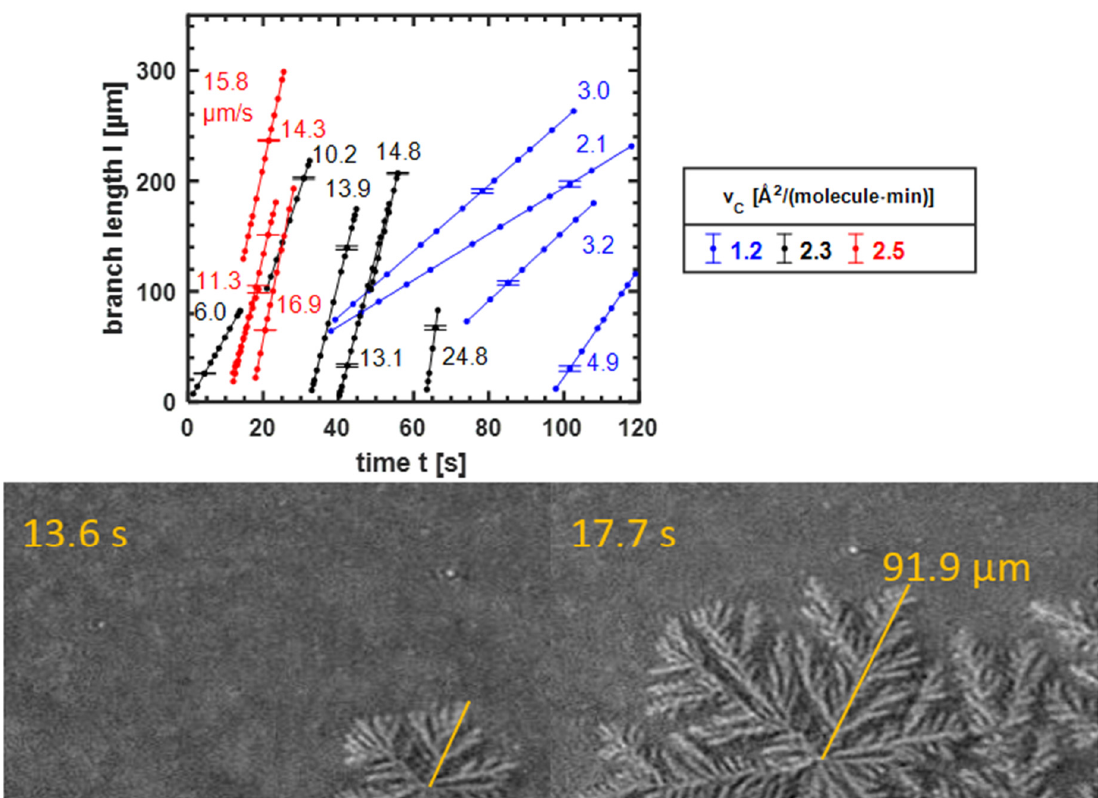
Figure 4. Bottom: Determining the length of a main branch at different times from BAM images of an erucic acid monolayer compressed at v C = 2.5 ˚A 2 / ( molecule · min ) ) (experimental conditions as in Figure 1). Top: The length of the main branch of different domains in dependence on the time t . Three monolayers were analyzed, each with a different compression speed v C as indicated. The lines are linear fits, whose slopes correspond to the constant growth velocity v R as indicated. Exemplary error bars are included. For each monolayer, t = 0 s refers to the first observation of a domain. For a selected domain, the lowest value of t corresponds to the first observation of this domain, when it is still very